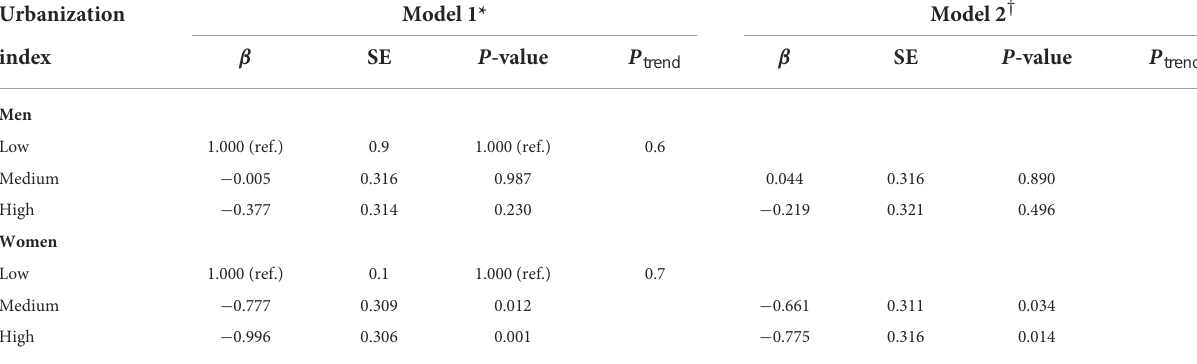
TABLE 2 Multilevel linear regression for the association between urbanization index and psychological stress, stratified by gender.